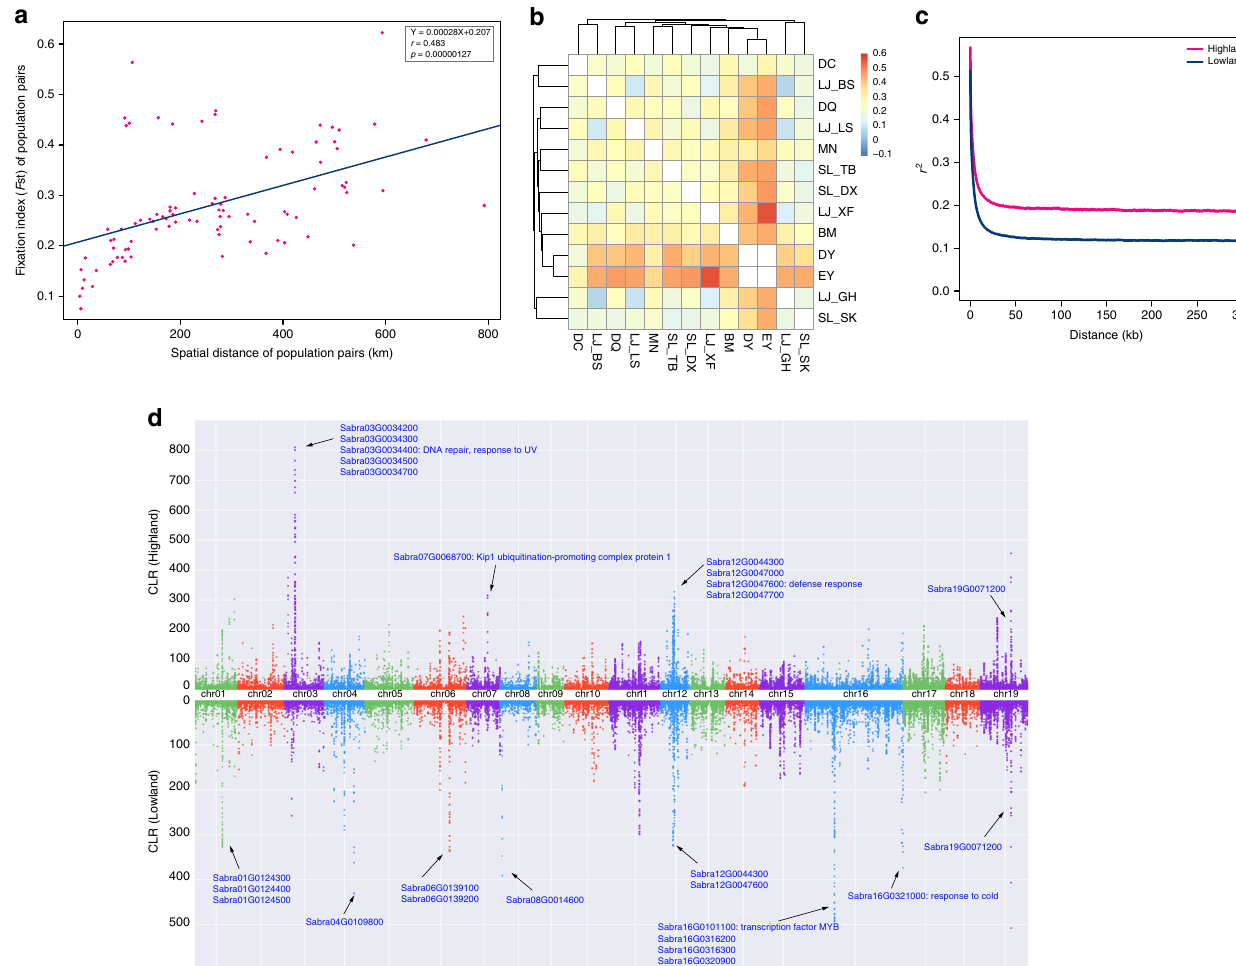
Fig. 4 Signatures of selection in Cushion willow sampled from high and lower elevation sites. a Pairwise F ST between populations ( y -axis) as a function of the pairwise spatial distance between populations ( x -axis). Each point represents one population pair. The solid blue line represents a signi fi cant linear relationship; parameter estimates for the linear regression, as well as Pearson ’ s correlation coef fi cient and associated p -value are given at the top-right corner of panel b . Heatmap of pairwise F ST estimates between populations. c Patterns of linkage disequilibrium (LD). LD ( y -axis) decays as a function of genomic distance between polymorphisms ( x -axis) in high elevation (solid red line) and low elevation (solid blue line) Cushion willows populations. LD was measured by r 2 . d Manhattan plots of CLR among the high and low elevation Cushion willow plants of LJ populations. Dashed line indicates CLR value threshold. Genes located within the signi fi cant CLR peaks and corresponding annotations are